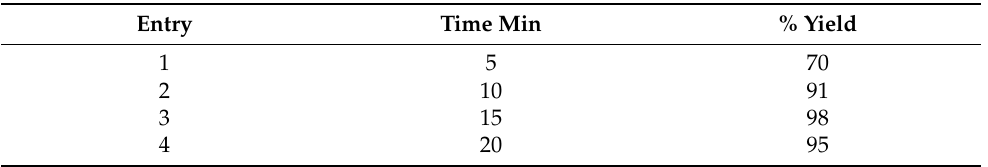
Table 2. Milling of 100 mg of 3,3 (cid:48) ,4,4 (cid:48) -biphenyltetracarboxylic anhydride and 174 mg of octyl aniline with 56.6 g of balls at 20